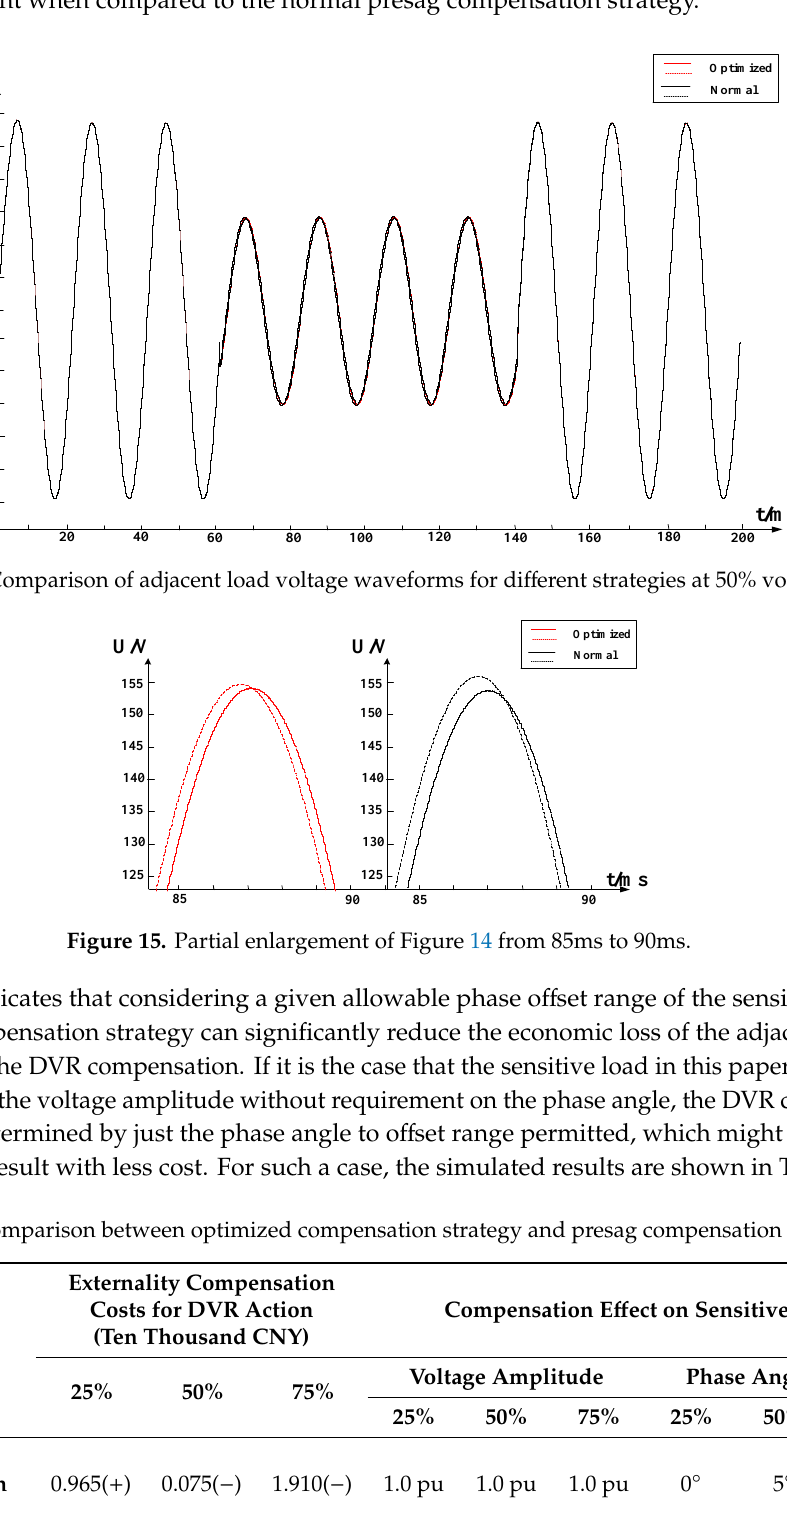
Table 5. Comparison between optimized compensation strategy and presag compensation strategy.